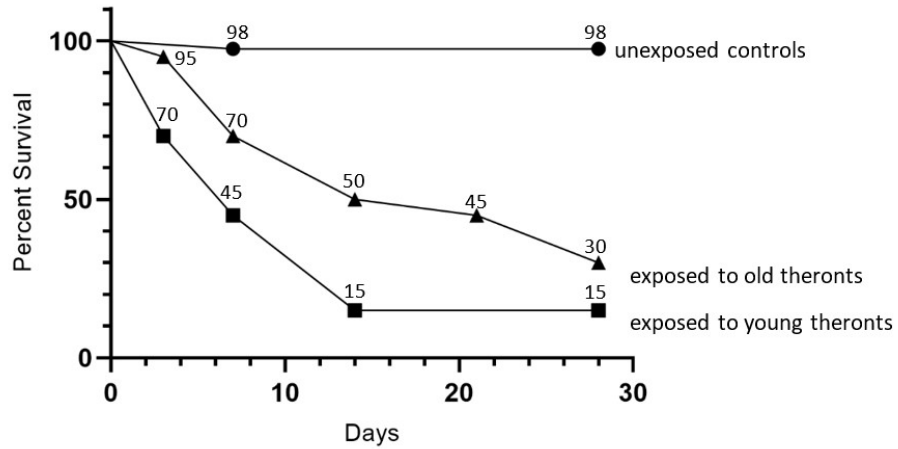
Figure 5. Kaplan–Meier survival plots of D. reticulatum slugs exposed to “young” newly excysted theronts, “old” 43-day stored theronts or untreated controls. n = 20 per treatment, n = 40 controls.